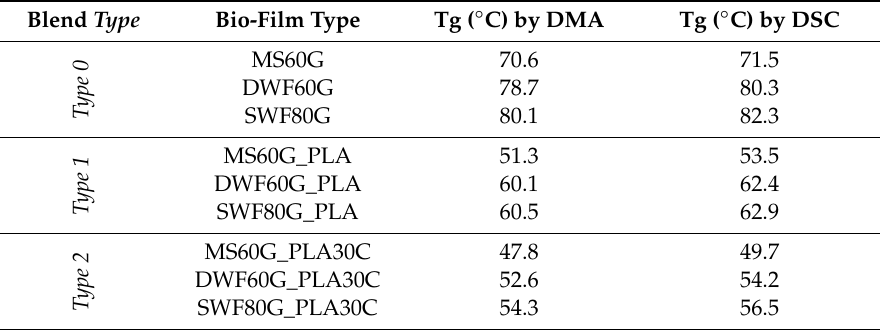
Table 3. Tg values of the maize starch (MS)-based, durum waste flour (DWF)-based and soft waste flour (SWF)-based bio-films as determined by dynamic mechanical analysis (DMA) and by di ff erential scanning calorimetry